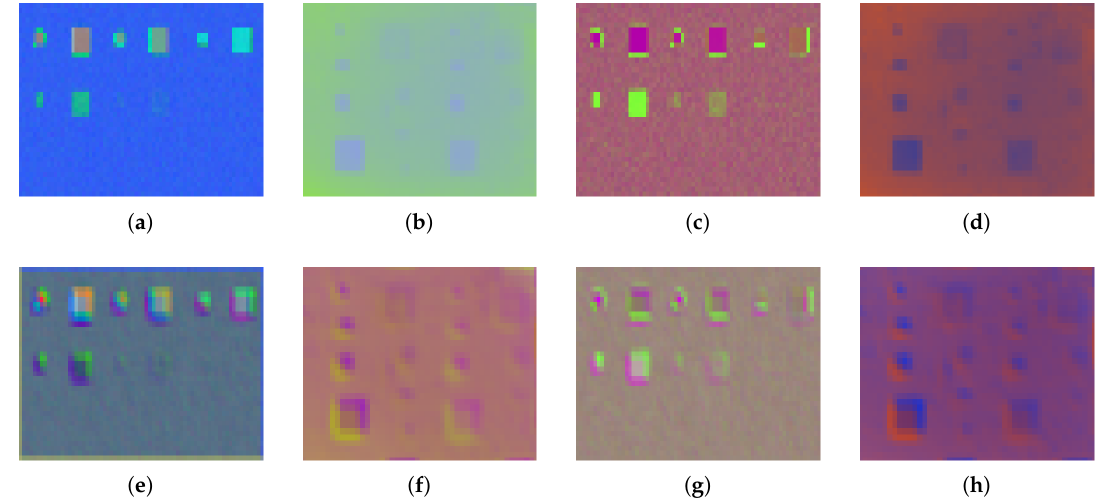
Figure 10. Original data and final results obtained with the application of quaternionic filtering by spatial convolution to the sequence obtained after QFT and QPCA: ( a ) result for QFT with direction 33 at frame 4, ( b ) result for QFT with direction 33 and frame 16, ( c ) result for QPCA at frame 2, ( d ) result for QPCA at frame 3, ( e ) result for QFILT applied to input ( a ), ( f ) result for QFILT applied to input ( b ), ( g ) result for QFILT applied to input ( c ), ( h ) result for QFILT applied to input ( d